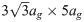
Illustration of the repeated unit cell of the calculations, seen from an angle looking directly down on graphene.The middle rectangle is the limit of one unit cell. The graphene C atoms are light gray large circles, the toluene C atoms are dark gray large circles, and H atoms are small circles. The covalent bonds between atoms are a guide to the eye only, bonds are not explicitly treated in DFT calculations but occur naturally e.g. from the electron density distribution, as in nature. The unit cell is orthorhombic (a box with right angles) with size 33ag×5ag (12.9 Å × 12.4 Å) in the plane of graphene. Here, ag = 2.48 Å is the lattice parameter of the primitive graphene unit cell in our calculations. The size of the unit cell in the direction perpendicular to the plane of graphene is 23 Å.